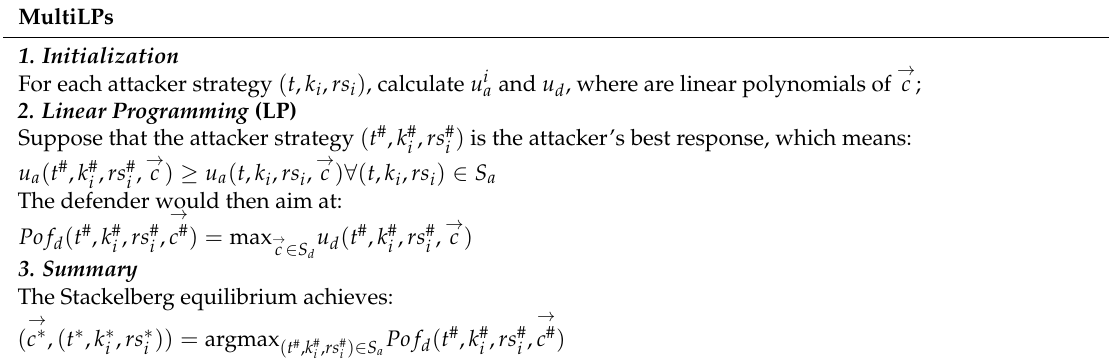
Table 3. MultiLPs algorithm for calculating the Stackelberg equilibrium for the Chemical Cluster Environmental Protection (CCEPP)